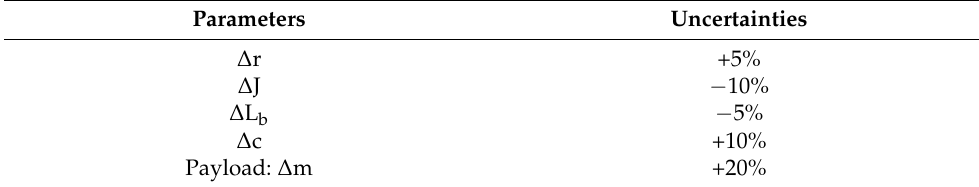
Table 4. List of the considered parameter